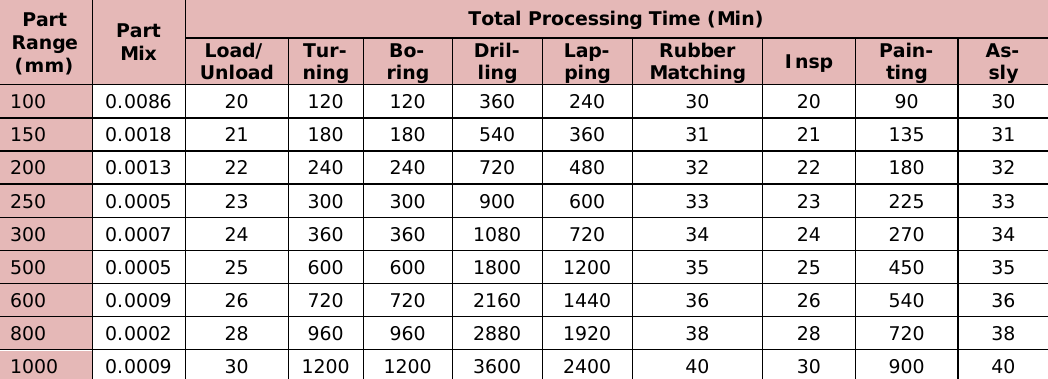
Table 1d. “Triple Eccentric Butterfly Valve”. Source: Own